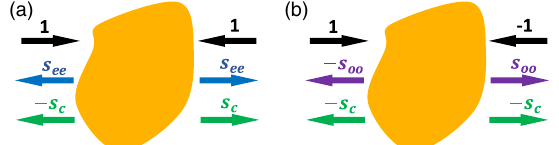
FIG. 6. Physical meaning of the scattering coefficients for the cases of (a) symmetric incident waves and (b) antisymmetric incident